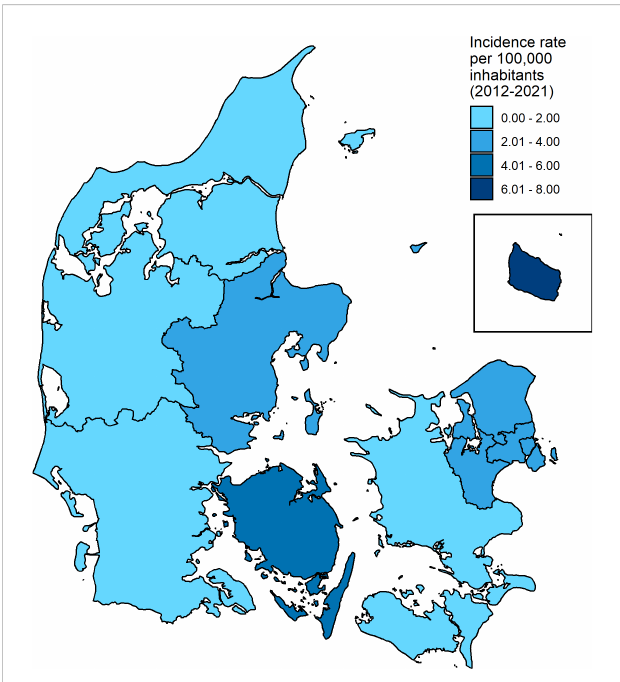
FIGURE 2 Geographical distribution by province of incidence rates per 100,000 of all cases over the entire study period in Denmark, 2012-2021.